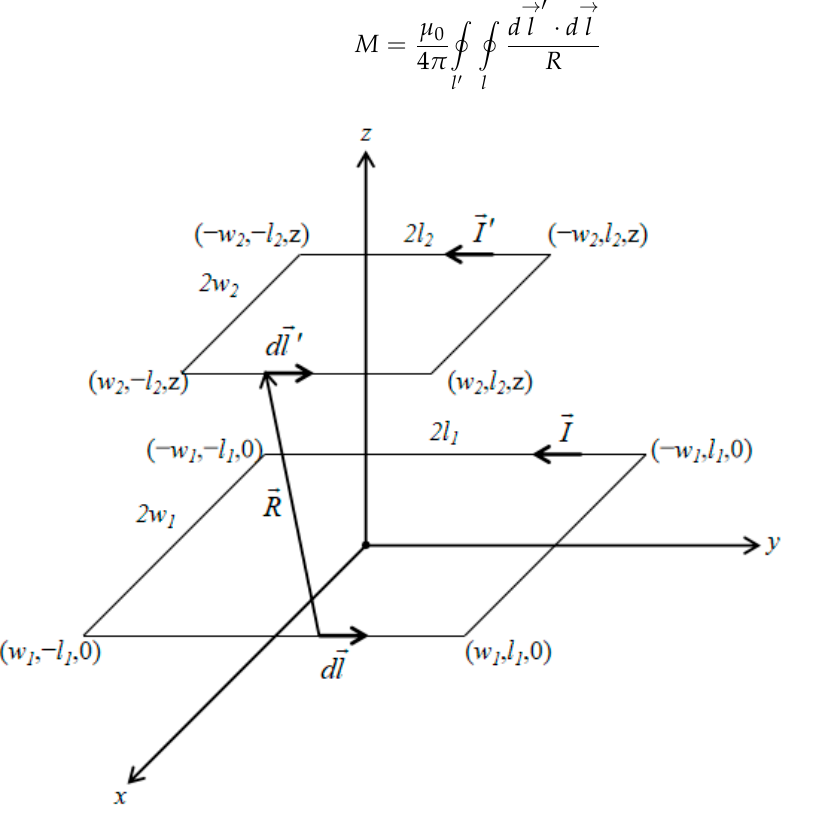
Figure 4. Mutual inductance model. Let the line element coordinates of the primary side be ( x 1 , y 1 , 0), and the line element coordinates of the secondary side be ( x 2 , y 2 , z). Substituting the coordinates of the two line elements into formula (1) can be simplified as below: